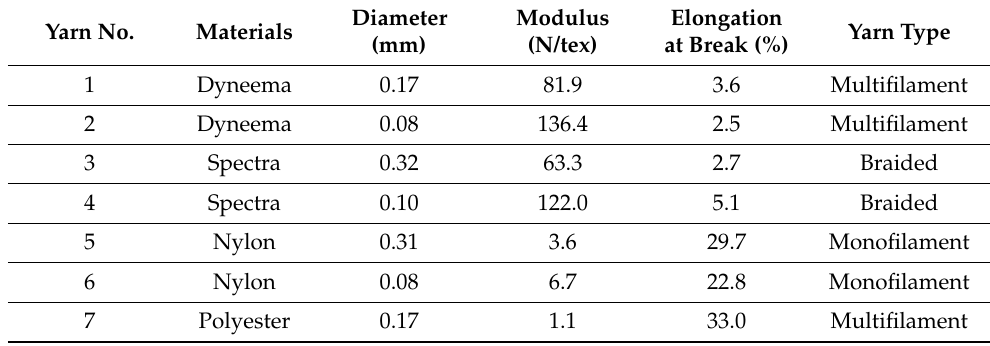
Table 1. Specifications of yarns used in